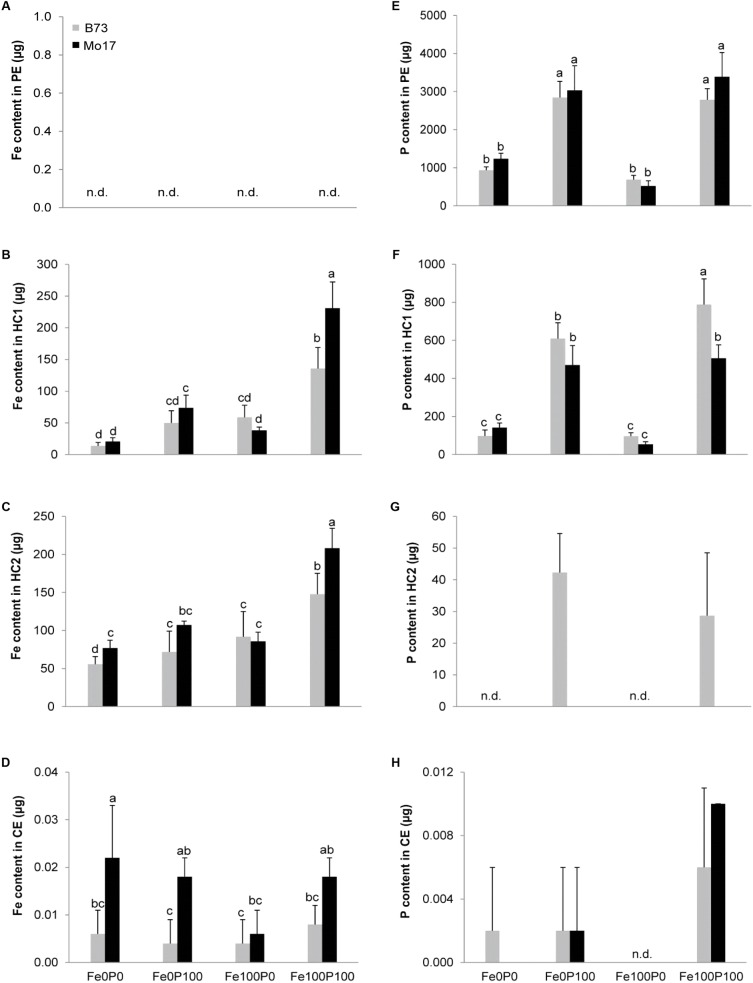
Differential partitioning of Fe and P in cell wall fractions of maize roots. (A–D) Fe contents in pectin (PE), hemicellulose fraction-1 (HC1), hemicellulose fraction-2 (HC2), and cellulose (CE); (E–H) P contents in pectin (PE), hemicellulose fraction-1 (HC1), hemicellulose fraction-2 (HC2), and cellulose (CE). B73 and Mo17 plants were grown for 15 days in nutrient solution supplemented without Fe and P (Fe0P0), without Fe and with 100 μM P (Fe0P100), with 100 μM Fe, and without P (Fe100P0) or with 100 μM Fe and 100 μM P (Fe100P100). Fe and P treatments were initiated after one week of preculture on full nutrient solution. 1 g of root cell wall material was sequentially extracted for fractionation. Bars indicate mean values ± SD, n = 5. Different letters denote significant differences at p < 0.05.